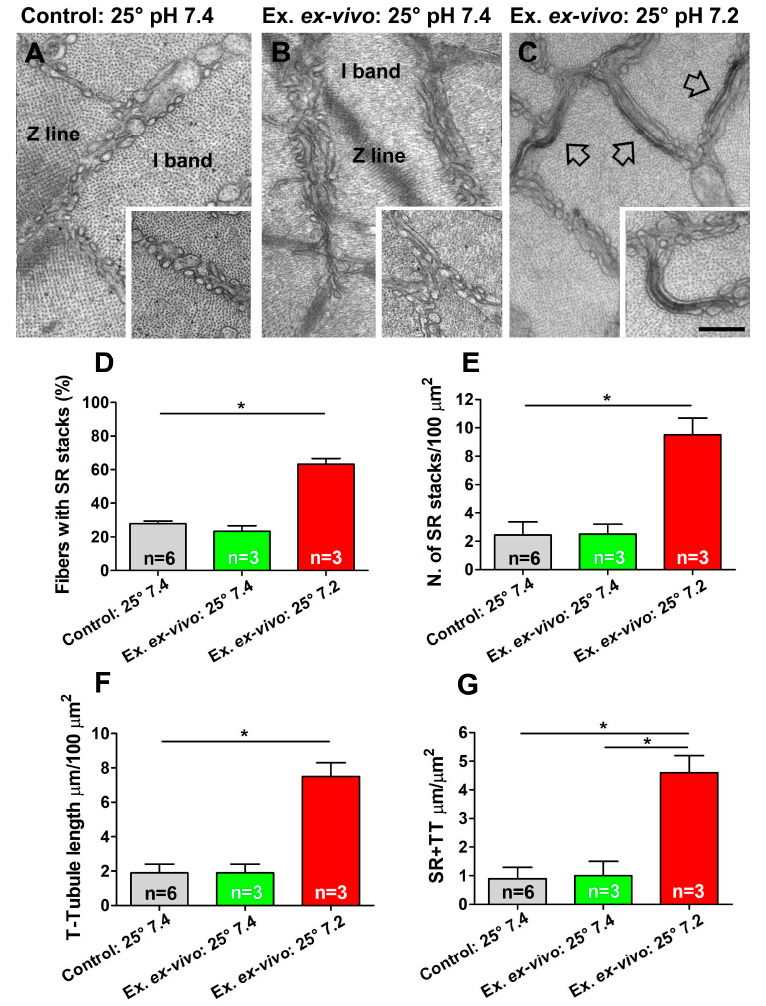
Figure 5. Electron-micrographs and quantitative analysis of assembly of CEUs at pH 7.4 vs. 7.2 (25 ◦ C) . ( A – C ) EM images in isolated EDL muscles that: (i) have rested at 25 ◦ C and pH 7.4 (panel ( A )); (ii) have been subjected to the ex vivo exercise protocol performed at 25 ◦ C and pH 7.4 (panel ( B )); and (iii) have been subjected to the ex vivo exercise protocol performed at 25 ◦ C and pH 7.2 (panel ( C )). The insets in panel ( A , B ) show SR appearance at the I band; the empty arrows and the inset in panel ( C ) show the remodeling of SR in stacks. ( D , E ) Percentage of fibers containing SR stacks and number of SR stacks/100 µ m 2 of section. ( F , G ) Extension of TTs at the I band in 100 µm 2 of section and analysis of SR-TT contact length. Data are shown as mean ± SEM (* p < 0.05). n = number of EDL analyzed. Scale bar: ( A – C ) = 0.1 µm; insets = 0.2 µm.